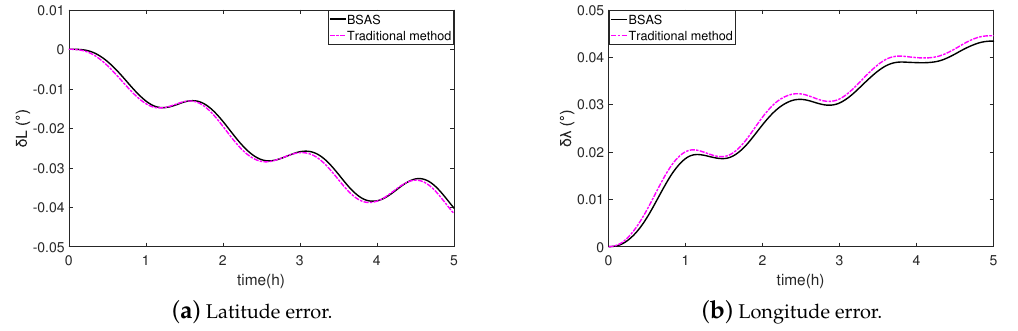
( b ) Longitude error.